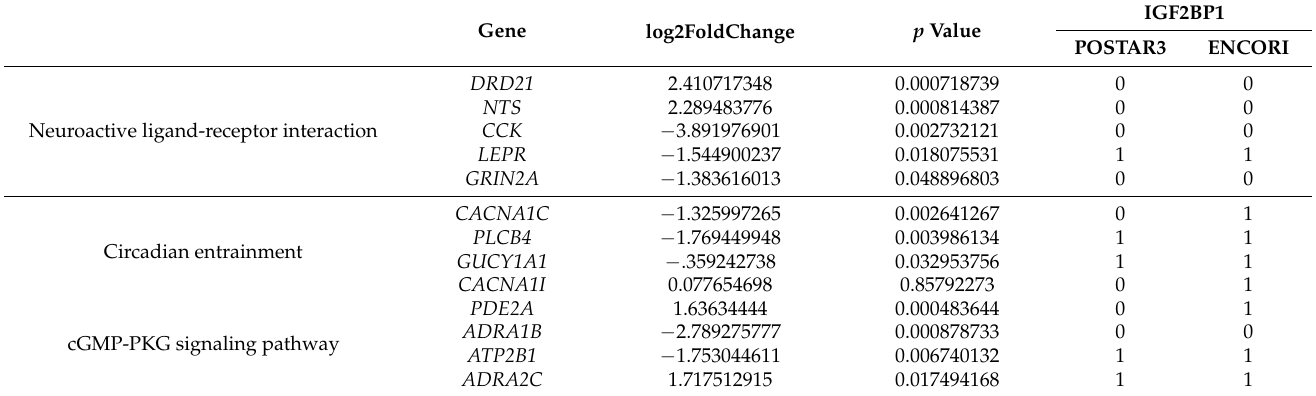
Table 1. The level of protein interaction and mRNA interaction between IGF2BP1 and some related differential genes in the neuroactive ligand–receptor interaction, circadian entrainment, and cGMP- PKG signal pathway.